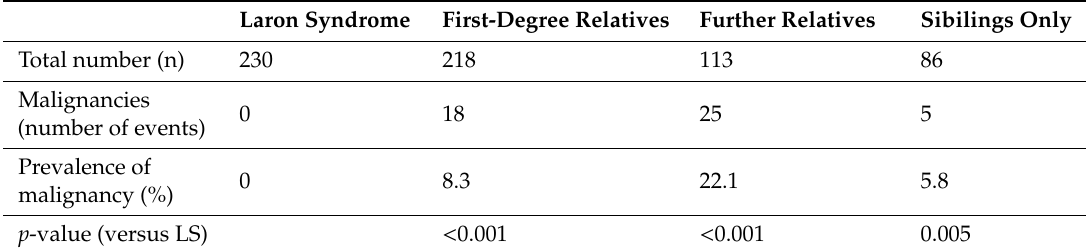
Table 1. Epidemiological analyses of cancer prevalence in Laron syndrome patients. Prevalence of malignancies in LS and relatives was assessed by replying to a questionnaire that was filled-in by the primary care physician (Adapted from